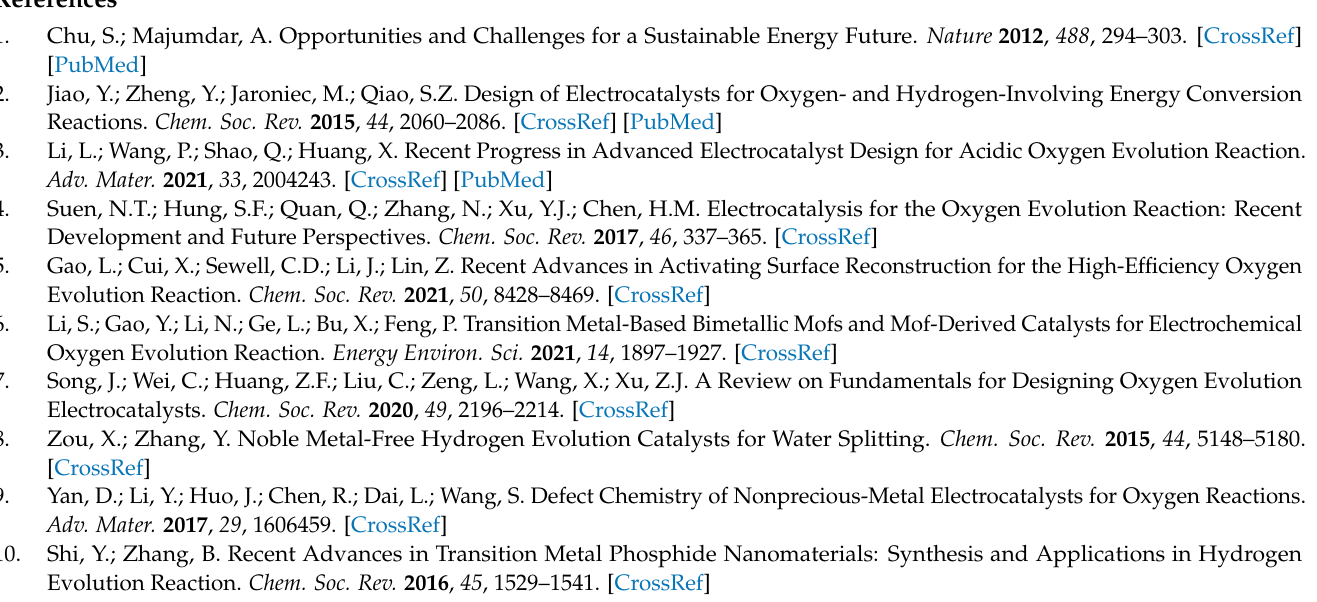
Figure S4. XPS spectrum of (a) NiMoO 4 , NiMoO 4 O 2 -Pl, NiFe PBA/NiMoO 4 , NiFe 2 O 4 /NiMoO 4 , and of (b) NiFe 2 O 4 /NiMoO 4 before OER and after OER. Figure S5. XPS (a) Ni 2p and (b) Fe 2p spectra of NiFe PBA/NiMoO 4 . Figure S6. XPS analysis of NiFe PBA/NiMoO 4 and NiFe 2 O 4 /NiMoO 4 . The core level spectra of (a) Ni 2p 3/2 and (b) Mo 3d. Figure S7. Cyclic voltammograms in a capacitive current region at various scan rates from 20 to 100 mV s − 1 . (a) NiMoO 4 , (b) NiMoO 4 O 2 -Pl, (c) NiFe PBA/NiMoO 4 , (d) NiFe 2 O 4 /NiMoO 4 . Figure S8. In situ Raman spectra of NiFe 2 O 4 /NiMoO 4